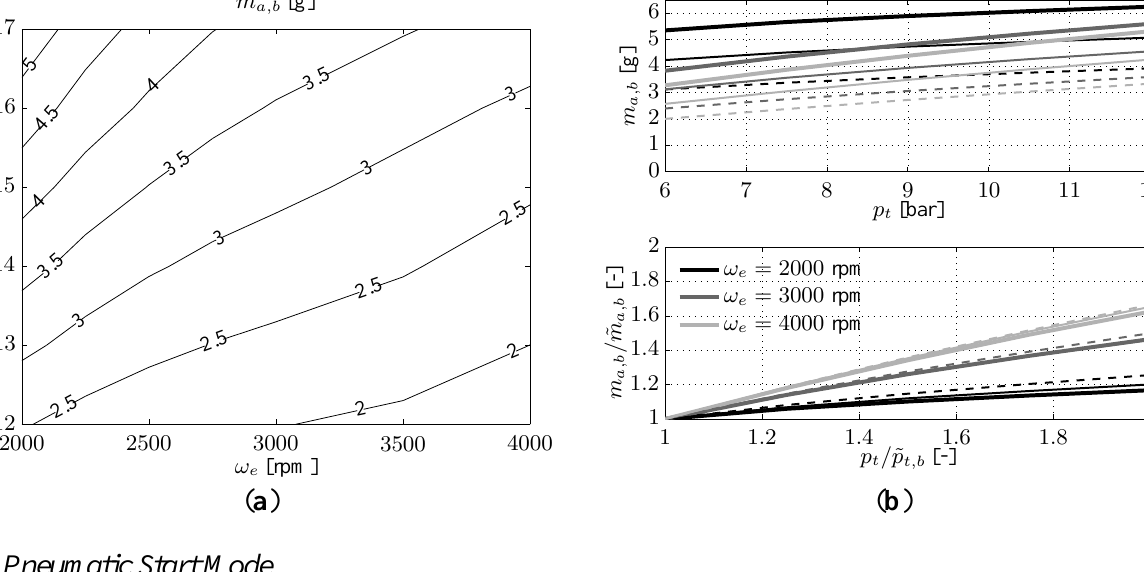
in the boost mode for a turbo lag compensation a,b ; and ( b ) air demand m = ˜ p t t,b = 13 bar . Thin solid: p = 15 bar . Thick solid: me me = 5 . 82 g / sbar CV,p